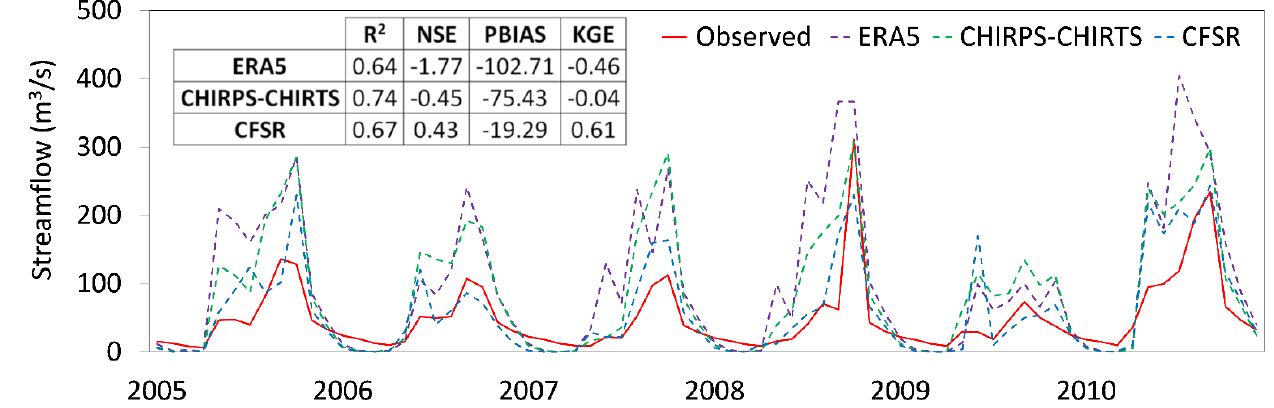
Figure 6. Model performance comparison for the default SWAT model using ERA5, CHIRPS-CHIRTS, and CFSR datasets for the input data together with monthly observed streamflows.